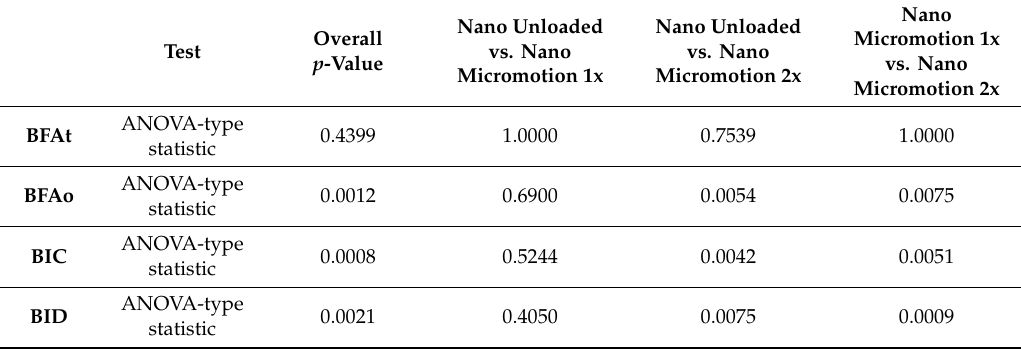
Figure 6. Histomorphometric analyses of bone formation in Nano Unloaded, Nano Micromotion 1x and Nano Micromotion 2x groups at 7 days post-surgery. The Nano Micromotion 2x group showed ( A ) overall lower BFAo; ( B ) lower bone implant contact (BIC), and ( C ) larger BID compared to the other two groups. Asterisks indicate statistically significant di ff erences. Table 2. p values of analyses. Bonferroni correction was applied for pairwise